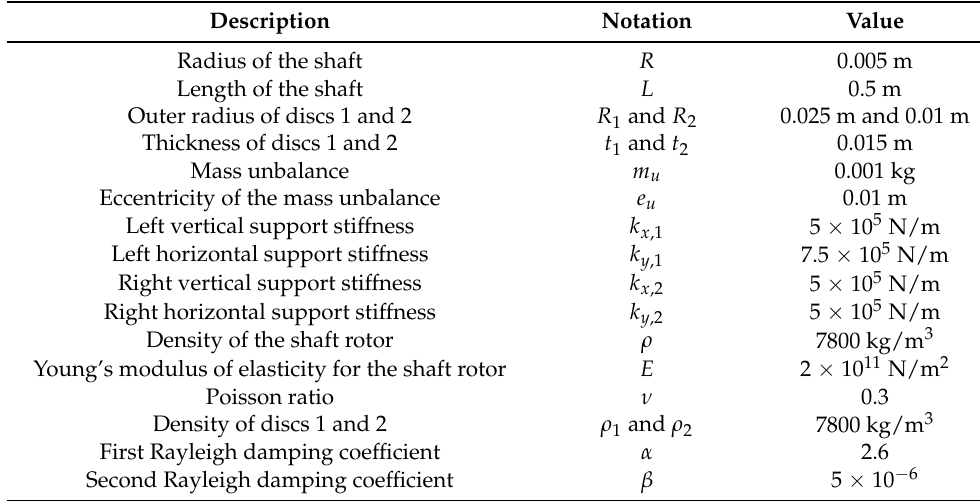
Table 1. Mechanical and geometrical properties of the rotor system. Description